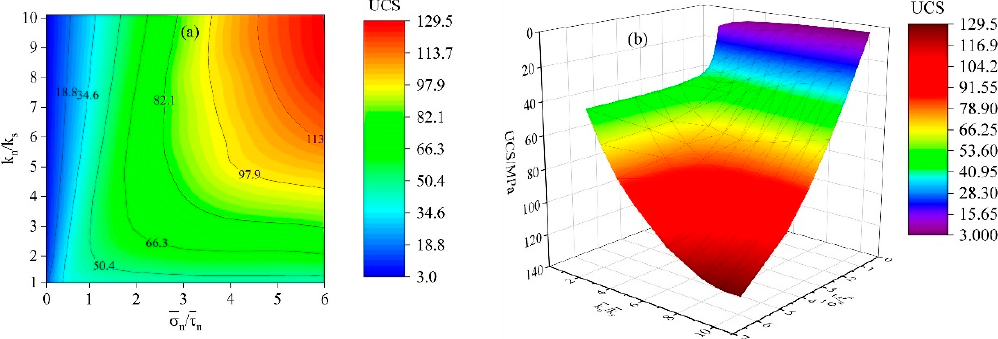
Figure 3. Response surface plots of uniaxial compressive strength (UCS). ( a ) Contour plot, ( b ) 3D surface plot.